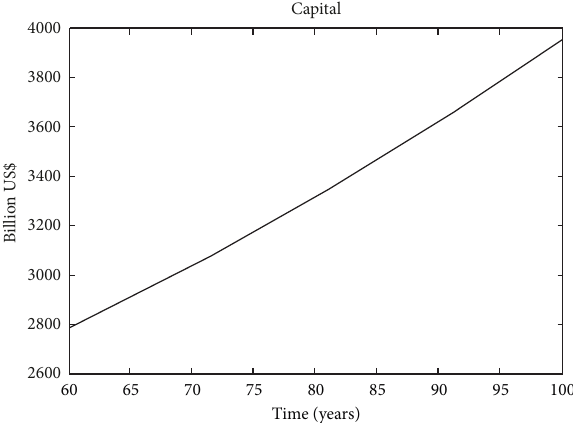
Figure 3: Graphical representation of billion US